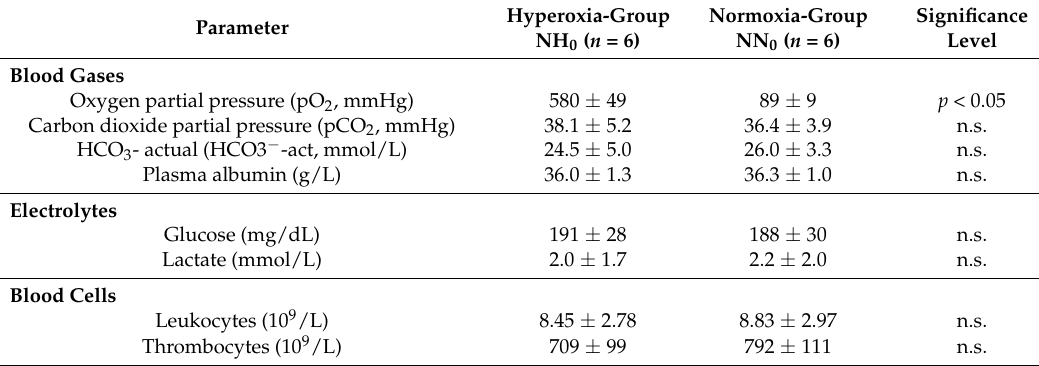
(Table 2) and were identified as 28 different proteins (brain: n = 9, lung: n = 10, kidney: n = 9). Table 1. Physiological parameters (hyperoxia group versus normoxia groups) immediately after normobaric hyperoxia exposure (3 h of 1.0 FiO 2